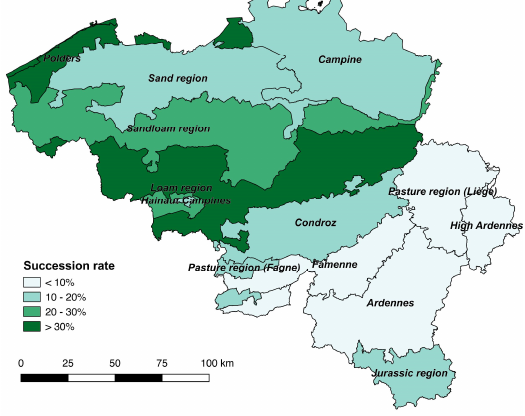
Figure 3. Succession rate for agricultural regions in Belgium.